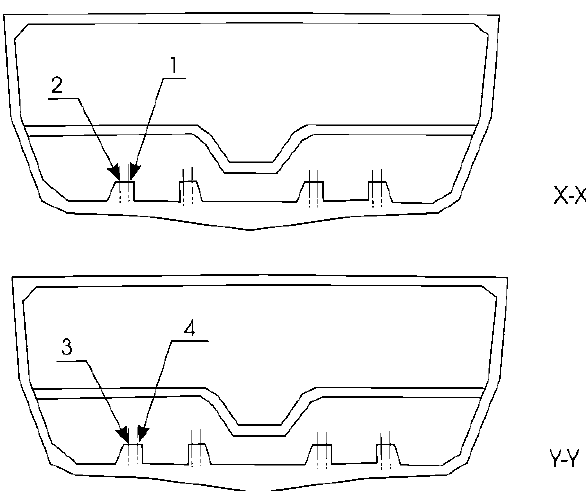
Figure 29: Separate cross sections X-X and Y-Y.